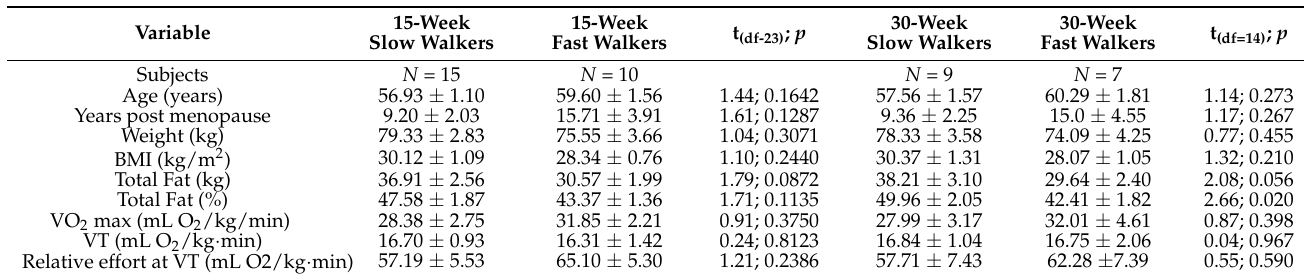
Table 2. Subject characteristics at baseline for the fast and slow subjects in the 15-week and 30-week